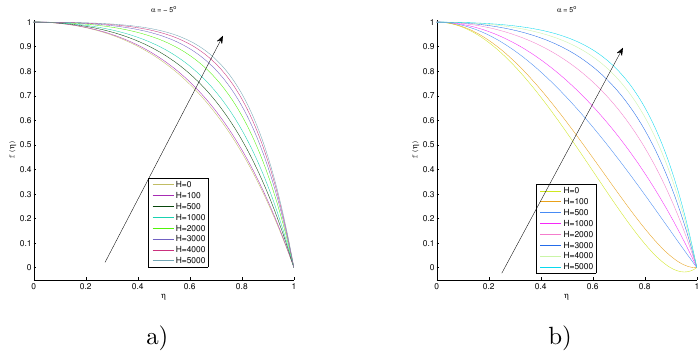
Figure 2. The 8 th -stage approximation obtained by the VPS for Re = 50 and a) α = − 5 0 , b) α = 5 0 .